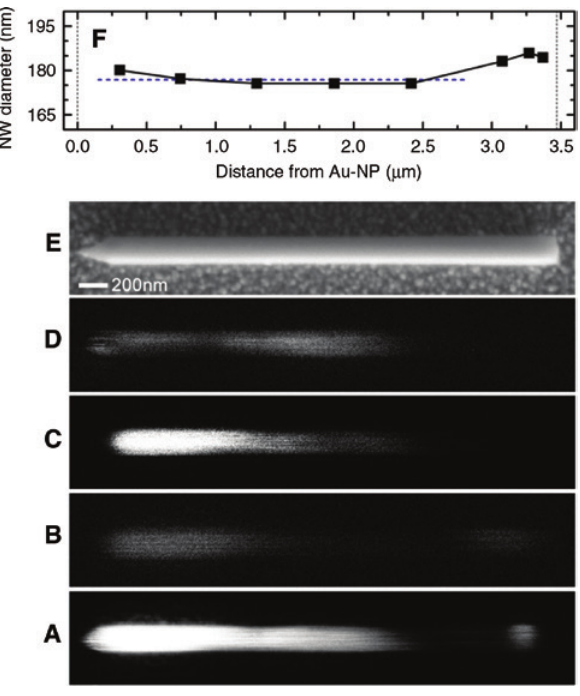
Figure 3: (A–D) Energy-selected CL images corresponding to the spectral intervals evidenced by the gray-hatched vertical regions in Figure 1B; the nanowire FE-SEM image has been superposed to the CL images to evidence the spatial origin of each CL contribution. The 200 nm marker in (D) holds for all images. (E) Values of nanowire diameters measured by FE-SEM at different positions along its length. The dashed horizontal line spans a relatively uniform diameter region corresponding to an average value of 151